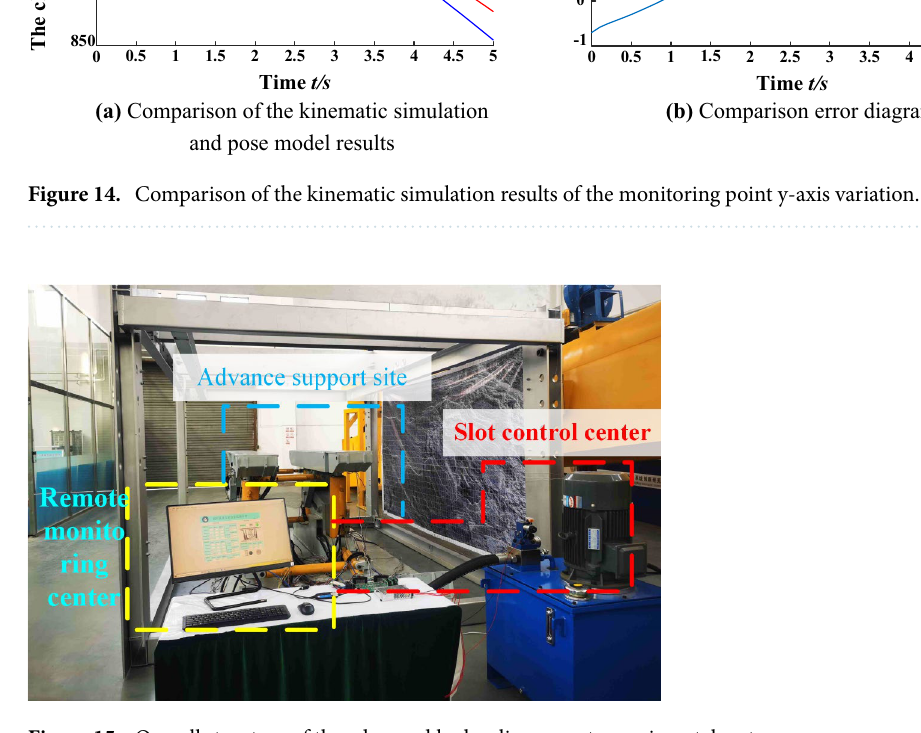
Figure 15. Overall structure of the advanced hydraulic support experimental